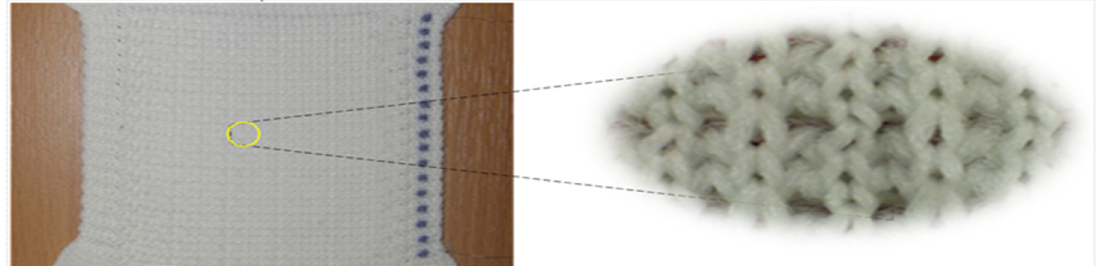
Fig. 1: An abstract graphic showing the insulated sensing element is being in-laid in the two layer structure of TSF